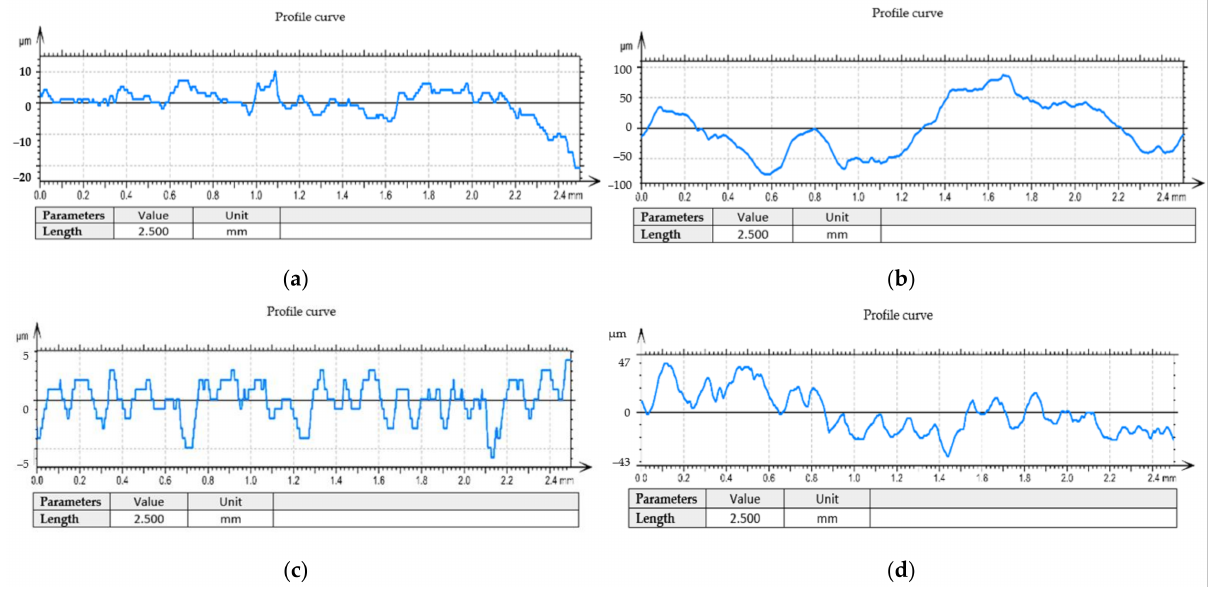
Figure 10. Profile curve: ( a ) in case of machining with the cutting tool T01 to the outside; ( b ) in case of machining with a T01 cutting tool inwards; ( c ) in case of machining with a T02 cutting tool to the outside; ( d ) in case of machining with a T02 cutting tool inwards.